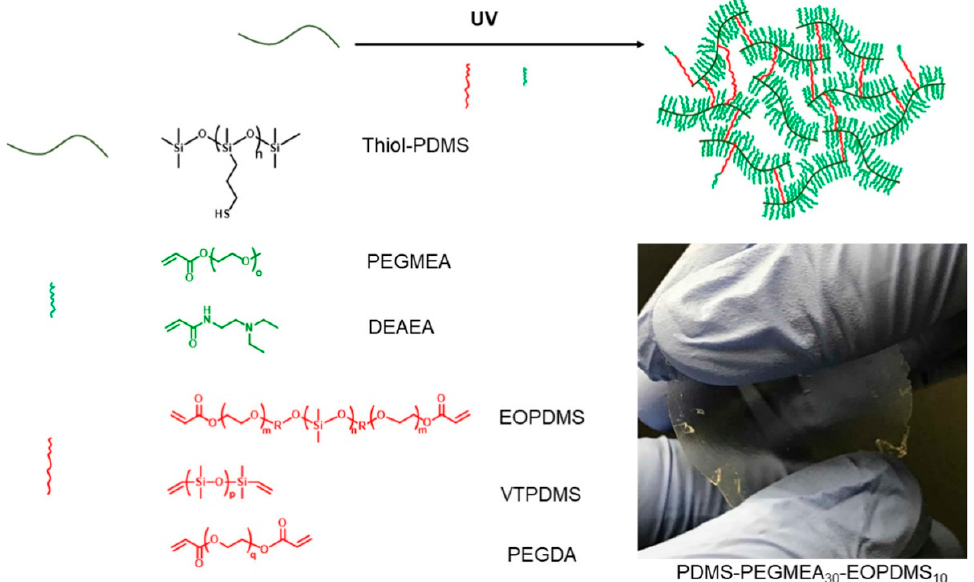
Figure 41. Preparation of elastomeric membranes. Reprinted/adapted with permission from Ref. [161]. Copyright 2019 American Chemical Society.